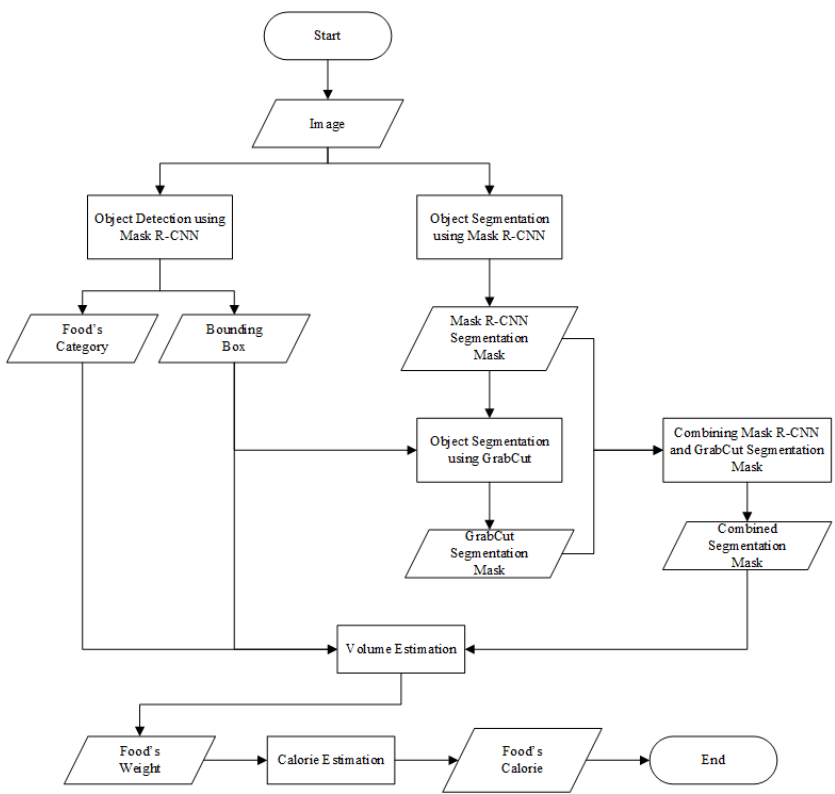
Fig. 1 The proposed system